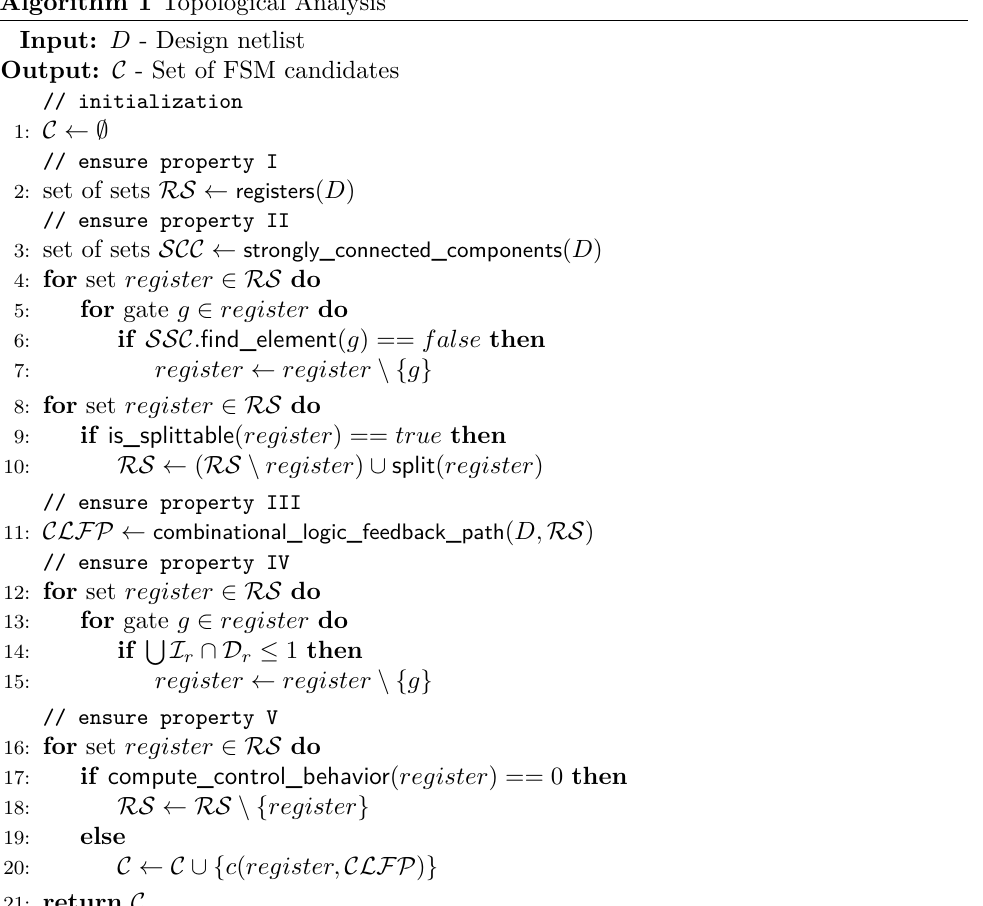
Algorithm 1 Topological